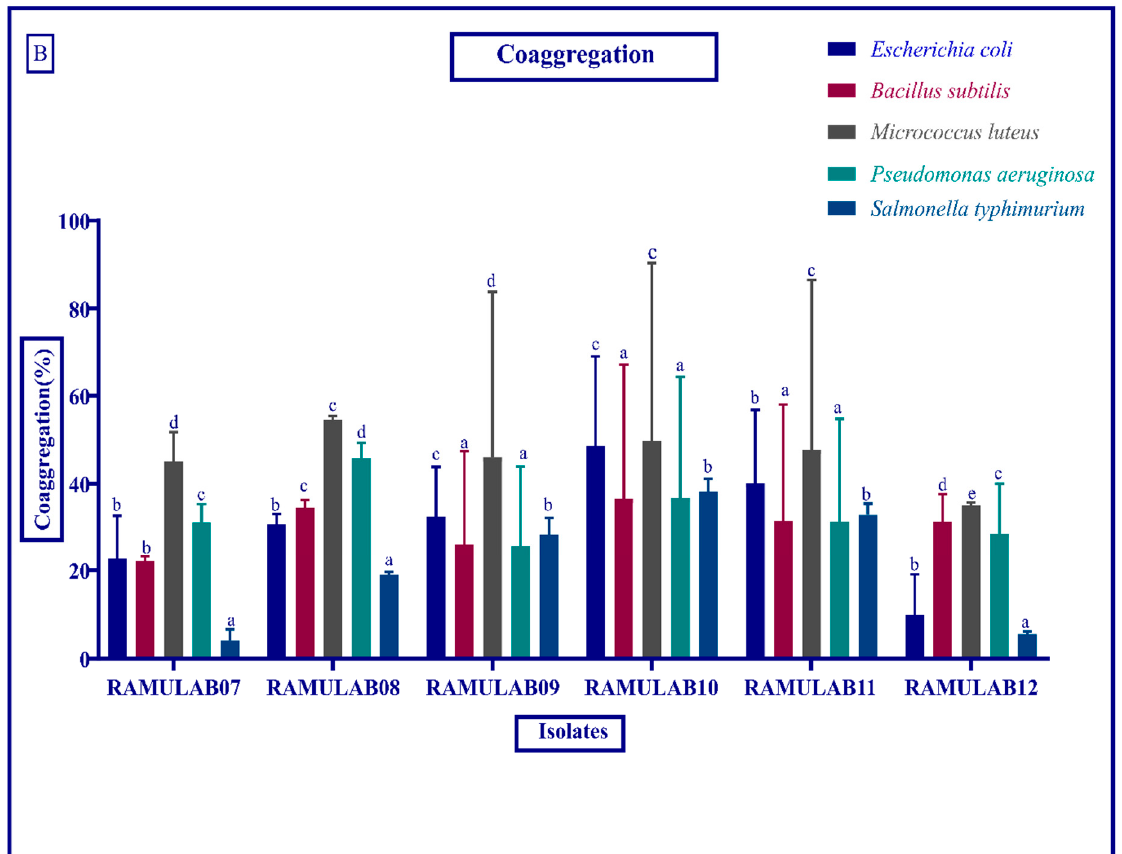
Figure 1. The ( A ) autoaggregation (%) strains at different time interval at room temperature and ( B ) coaggregation (%) of LAB strains after incubation of 2 h at room temperature. Data are expressed as the mean ± SD. Means in aggregation for 2 h with distinct superscripts (a–e) are significantly different ( p ≤ 0.05), as separated by Duncan multiple range test.